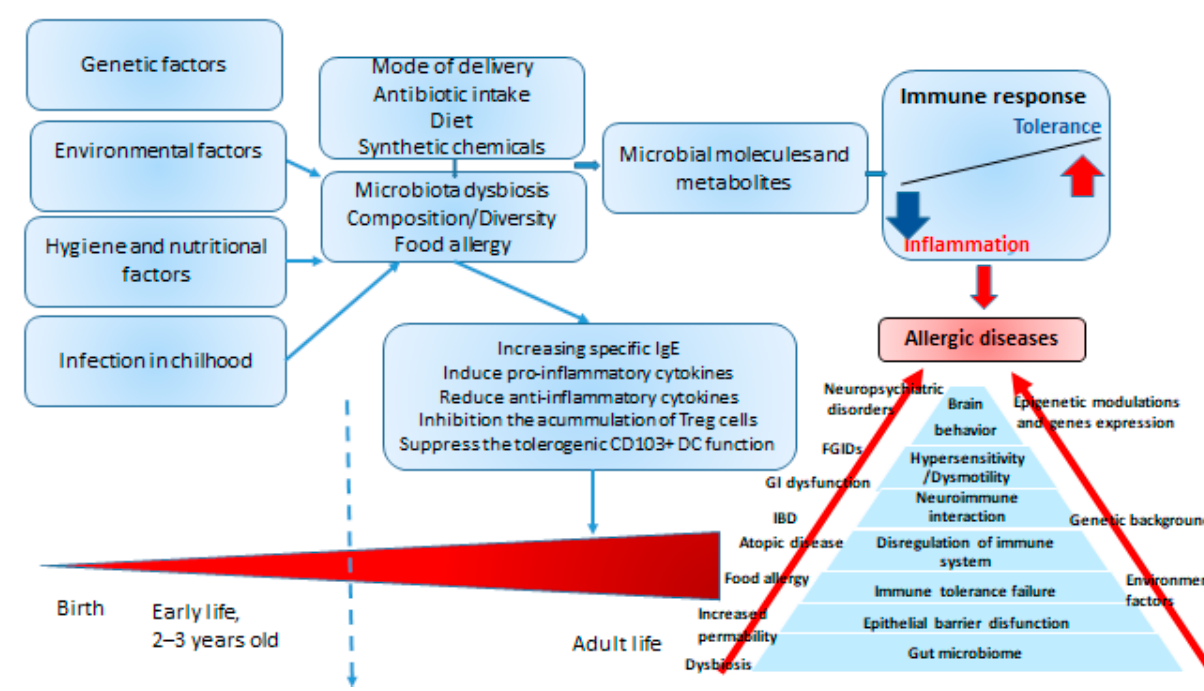
Figure 5. Numerous factors affect the development of the infant gut microbiome composition. The neonatal microbiome is a delicate and highly dynamic ecosystem that undergoes rapid changes in composition in the first few years of life determined by several prenatal (maternal genetic, environ- mental, diet, use probiotics, prebiotic, geographic location); natal (mode of delivery vaginal or ce- sarean, birth weight, gestational age) and postnatal factors (breast milk, use of antibiotics or gastric acidity inhibitors, use of antiseptic agents, rural environment, junk food-based and/or low-fi- ber/high-fat diet, consumption of unpasteurized milk or fermented foods, reduced consumption of omega-3-polyunsaturated fatty acids or vitamin D insufficiency, antioxidants, exposure to pets). All genetic, environmental, and dietary factors could modulate the gut microbiome-immune system axis influencing the occurrence of food allergy. The process of early colonization by a “healthy” microbiome is emerging as a key determinant of life-long health. In stark contrast, the perturbation of such a process, which results in changes in the host-microbiome biodiversity and metabolic ac- tivities, has been associated with greater susceptibility to immune-mediated disorders later in life, including allergic diseases.